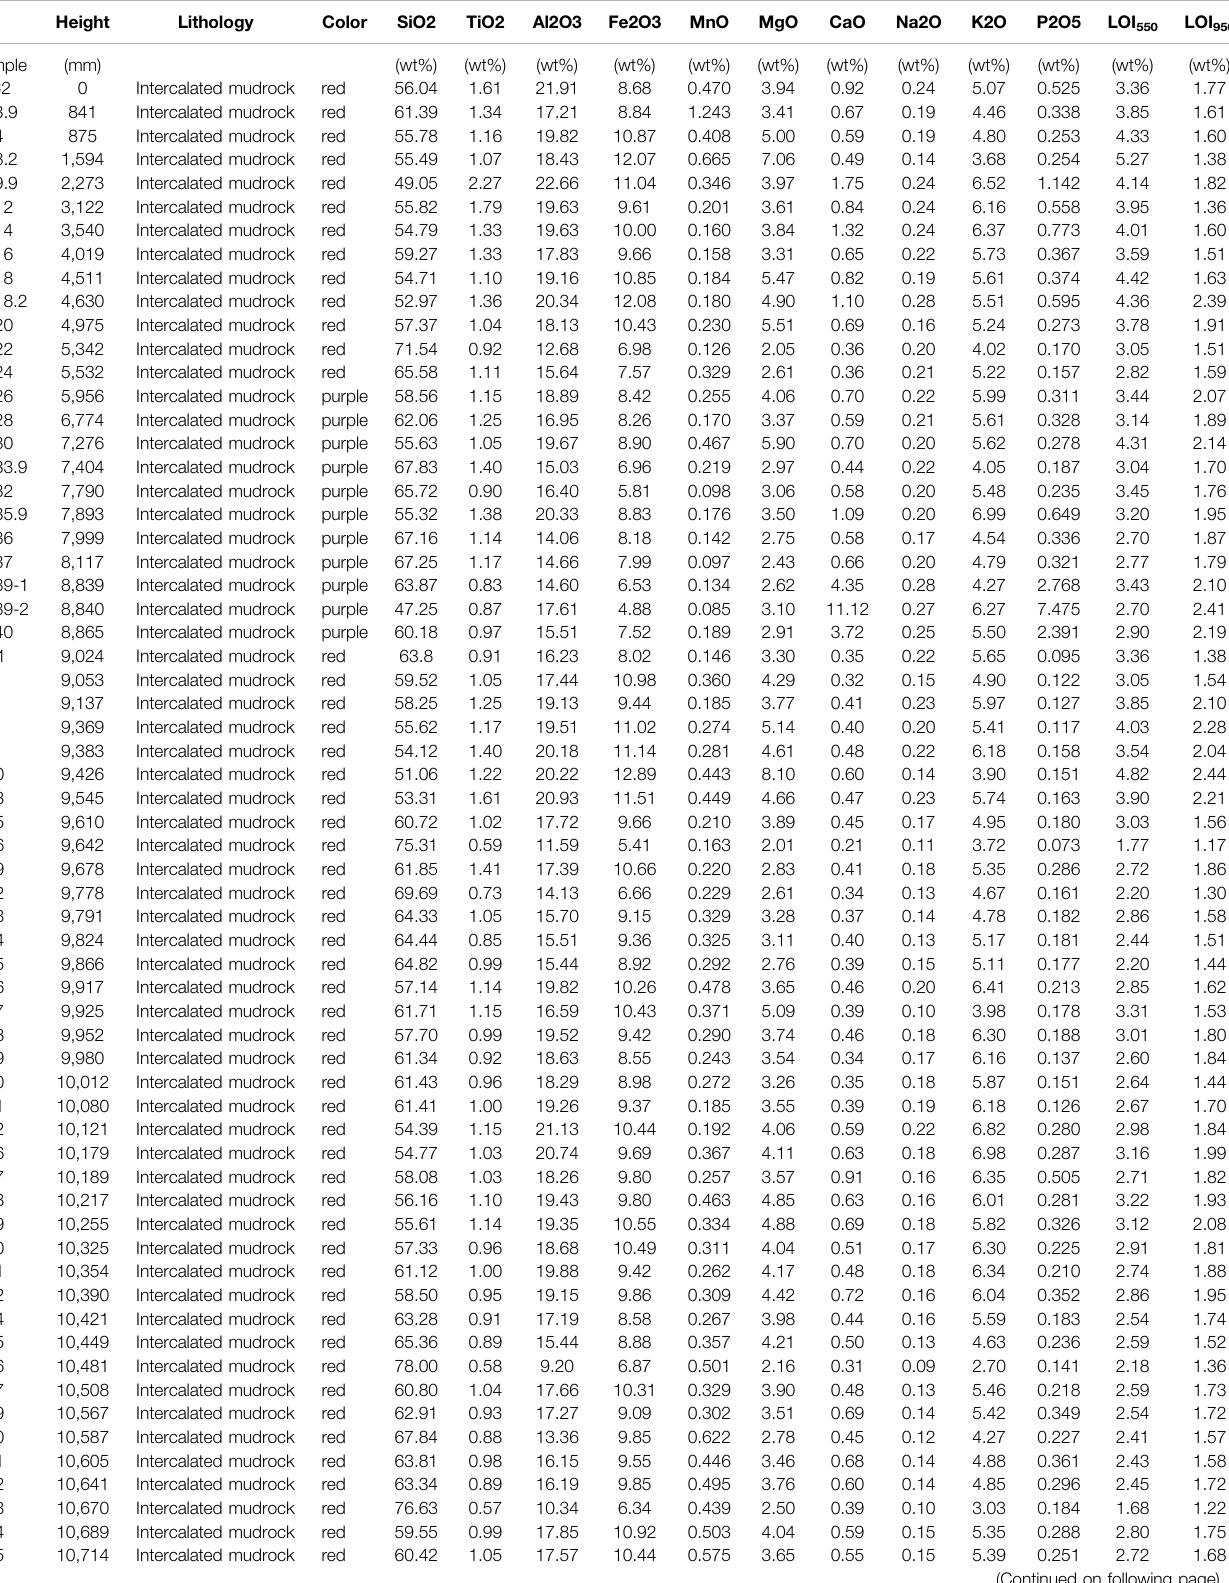
TABLE 1 | Major element composition of bedded chert samples collected in this study. Height